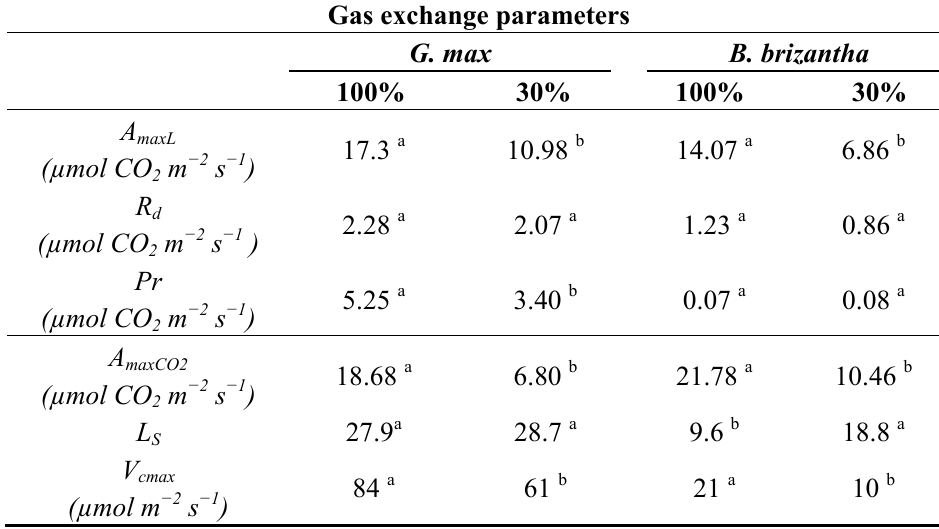
), dark respiration ( R maxL